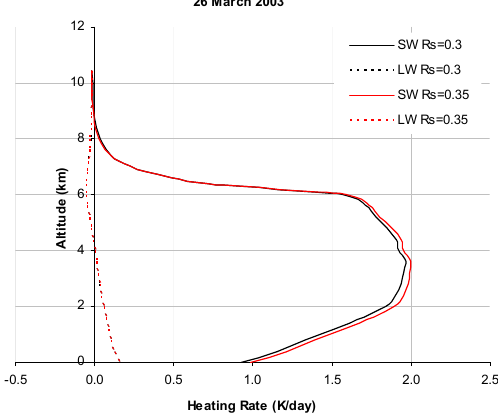
Fig. 13. SW and LW heating/cooling rate variations with altitude on 26 March for surface reflectivity of 0.3 and 0.35. Most of the heating is well within the dust layer and drops sharply to zero above 6km, which is the upper boundary of the dust layer.